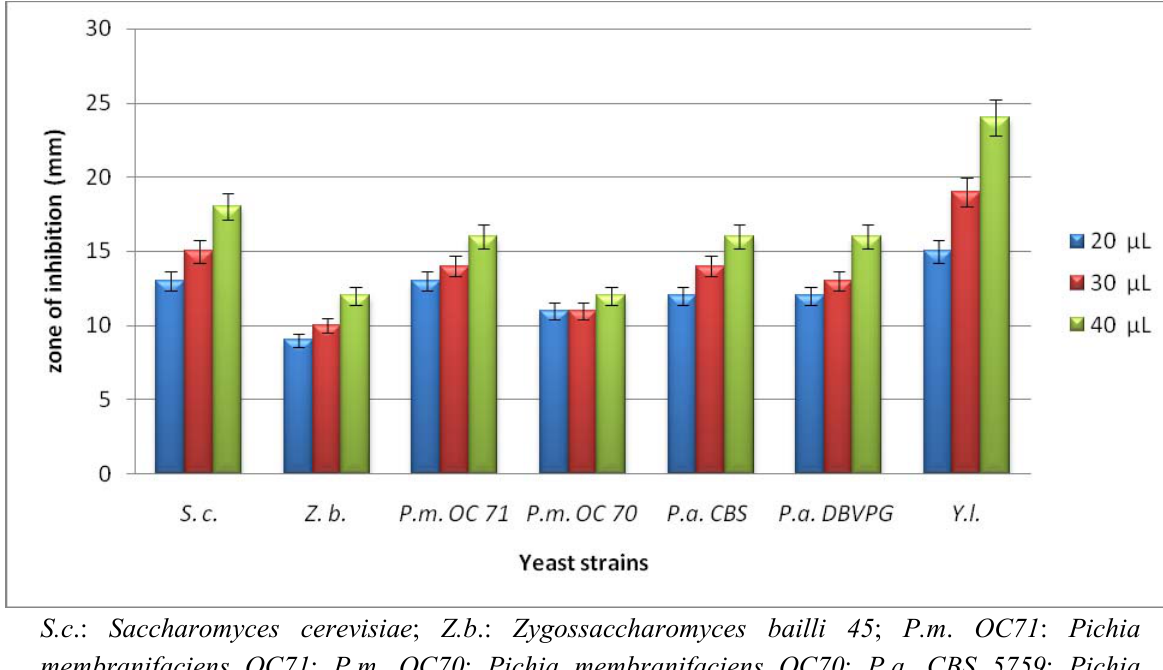
Figure 3. Zone of inhibition (mm) due to different concentrations (20, 30 and 40 µL) of P. cordaeana methanol extract against different yeast